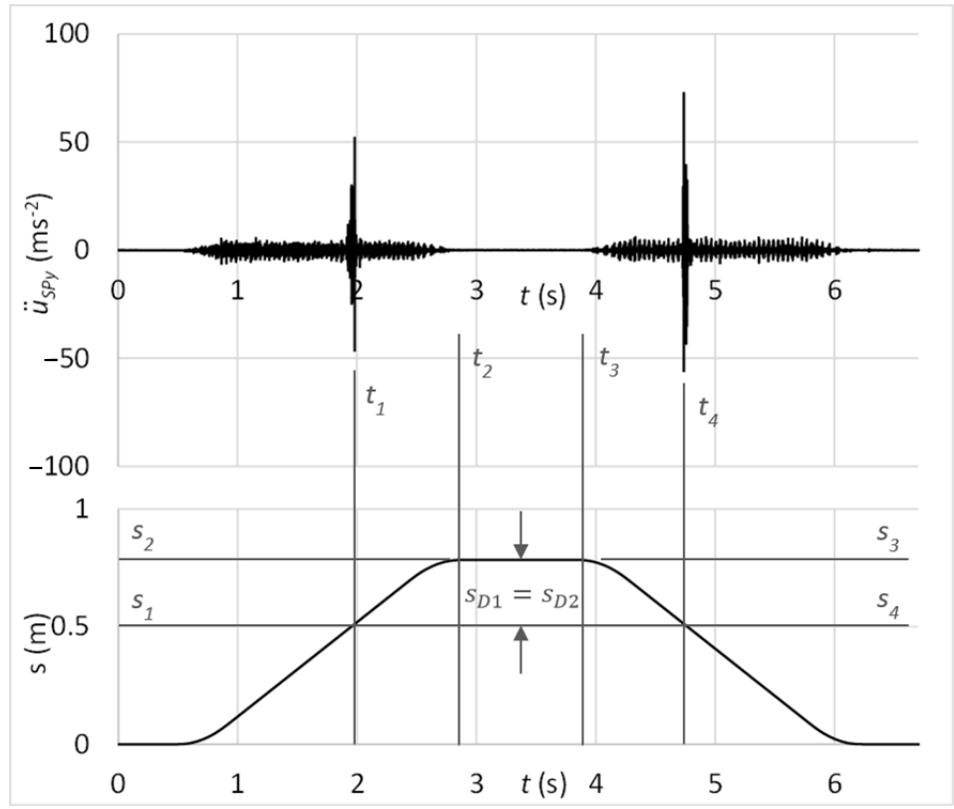
Figure 19. Acceleration of vibrations in the context of distance by the damage of the guiding profile and sensor connection with the rubber spring and additional weight.